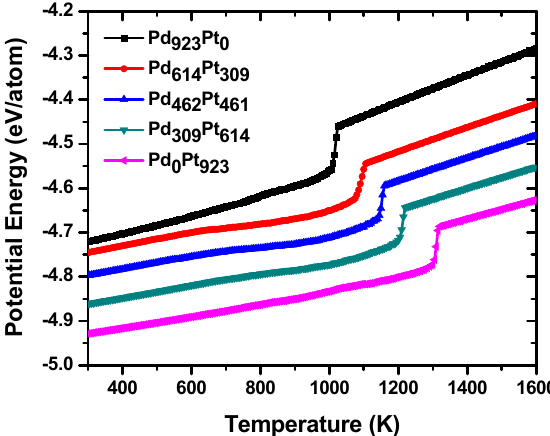
Figure 3. Temperature-dependent average potential energy of nanoparticles. In the graph, the values of the potential energy for each nanostructure were rescaled so that the distinctive features of each curve could be better appreciated.